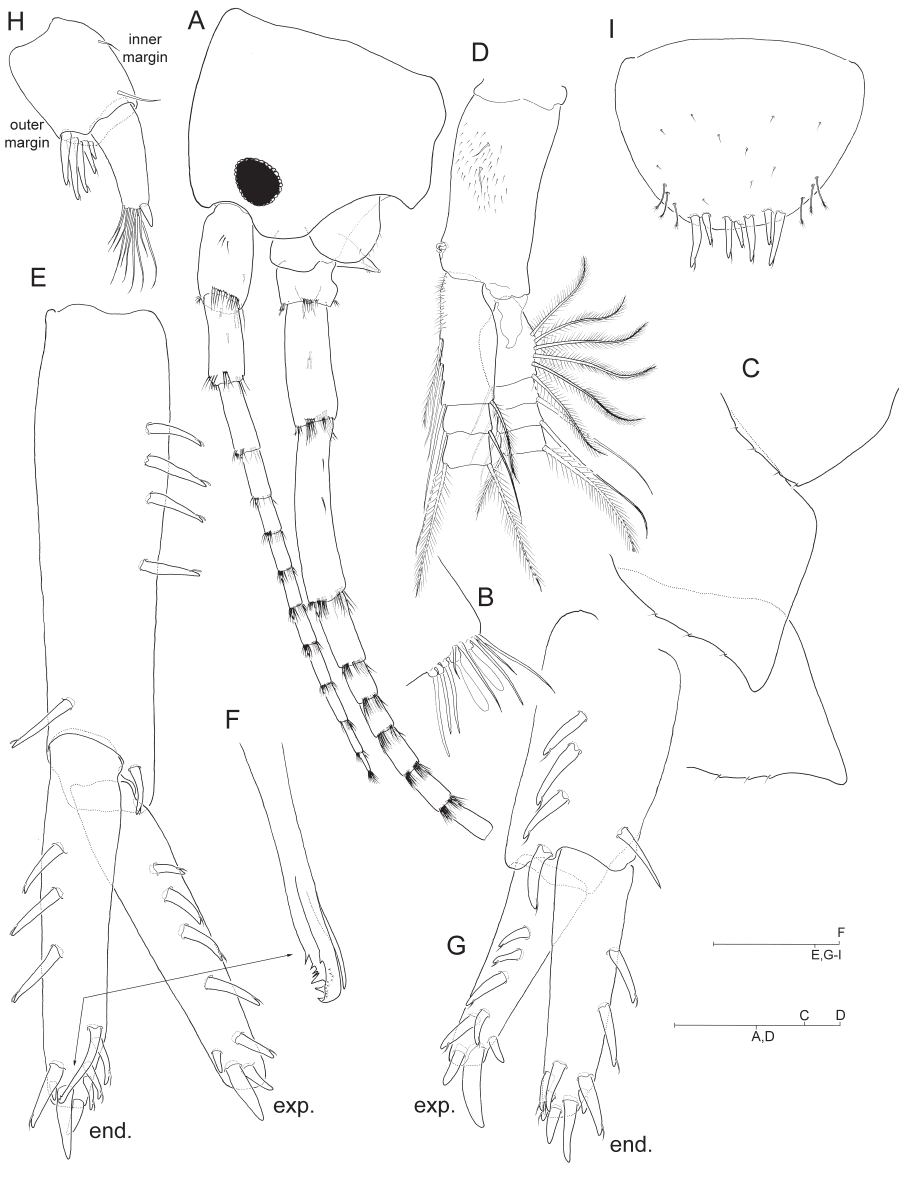
Figure 1. Hyalella cajasi sp. n., male. A head with left antenna 1 and antenna 2 attached, lateral B inset of distomedial armature on posterior margin of articles 3-6 of antenna 1 C right epimeral plates D right pleopod 3, posterior. Scale bars: 0.2 mm ( A, D ); 0.1 mm ( B ); 0.5 mm ( C, E, G–I ); 0.05 mm ( F ). medial margin of segment unarmed. Exopod with series of five flagellate robust setae along lateral margin and three robust setae on tip, none of which flagellate; medial mar- gin of segment unarmed. Endopod with four flagellate robust setae along medial